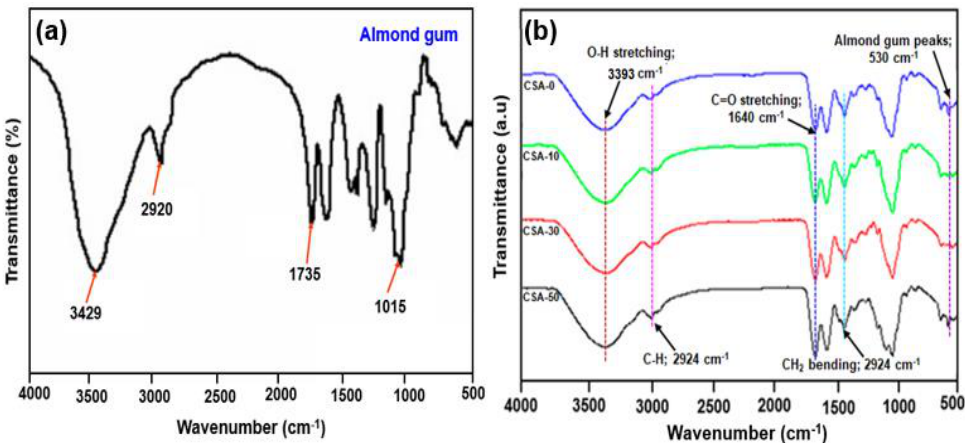
Figure 1. FTIR spectra of ( a ) almond gum; ( b ) chitosan, CSA-10.0, CSA-30.0, and CSA-50.0 compo-